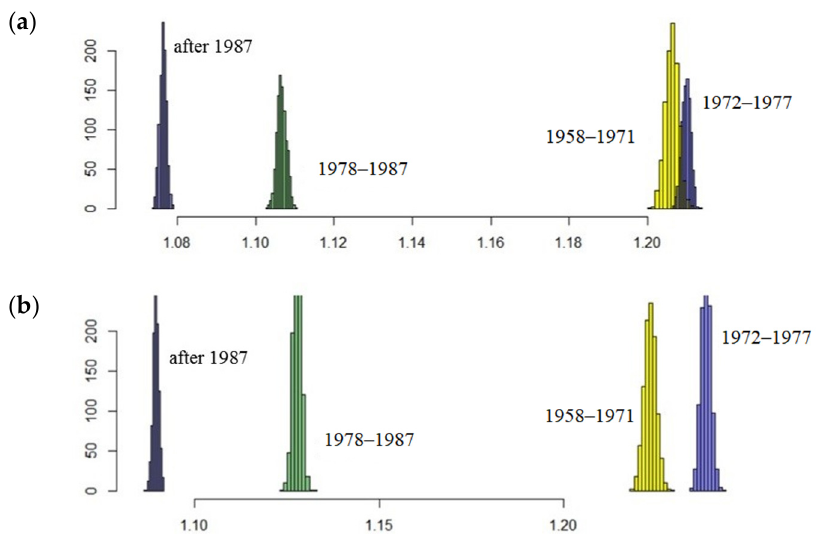
Figure 8. Expected rate of population growth λ e distributions in random samples (1000 iterations) for each period; here, ( a ) corresponds to parameter estimates obtained by the iteration and ( b ) refers to the fitting method.